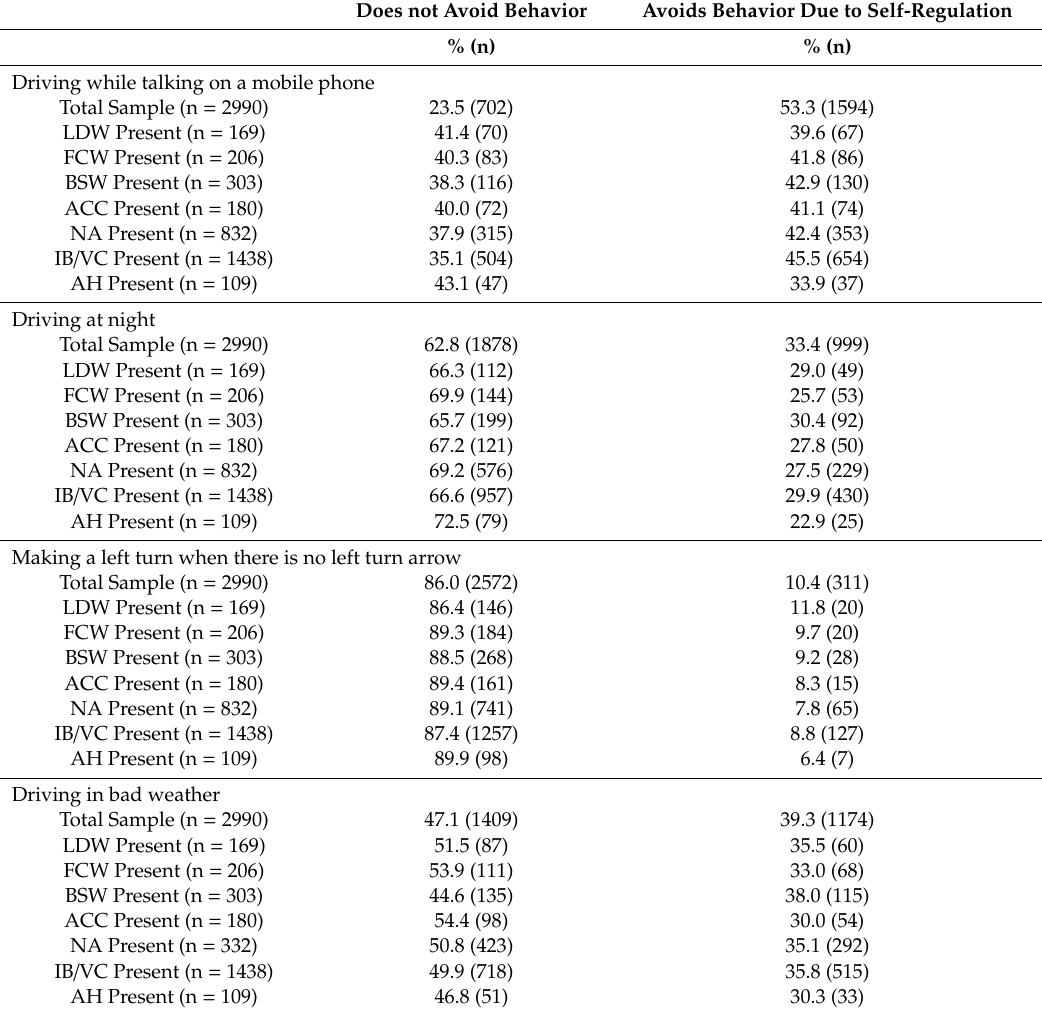
Table 3. Proportion of Older Drivers Who Engage in Self-Regulatory Behavior, by In-Vehicle Technology